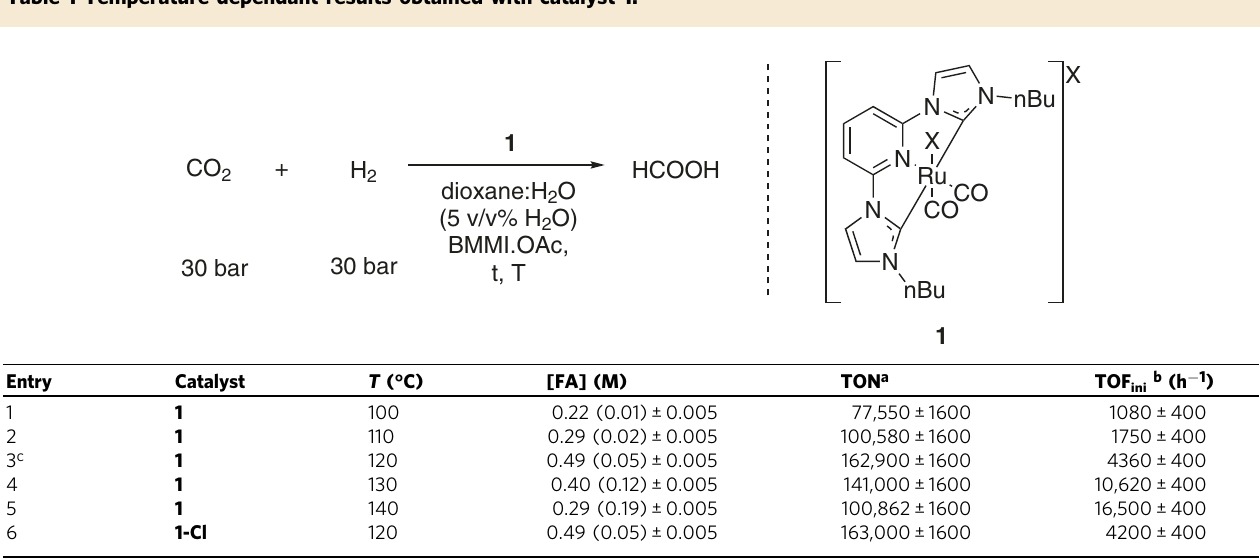
Table 1 Temperature-dependant results obtained with catalyst 1.